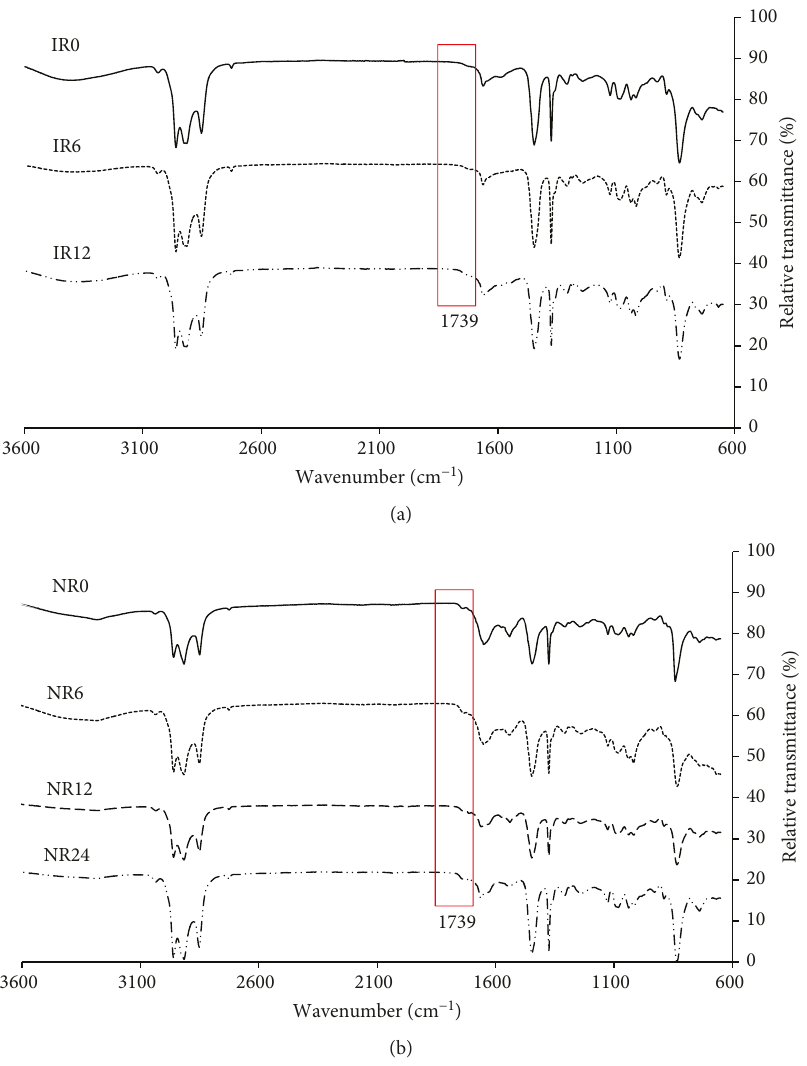
Figure 12: FT-IR spectra of (a) IR masticated for 0, 6, and 12 minutes and (b) NR masticated for 0, 6, 12, and 24 minutes.